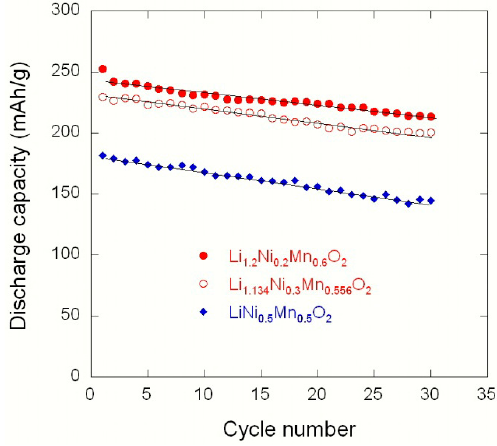
Figure 23. Cyclic performance of Li//Li(Ni x Li (1/3-2x/3) Mn (2/3-x/3) )O 2 electrodes at C/10.